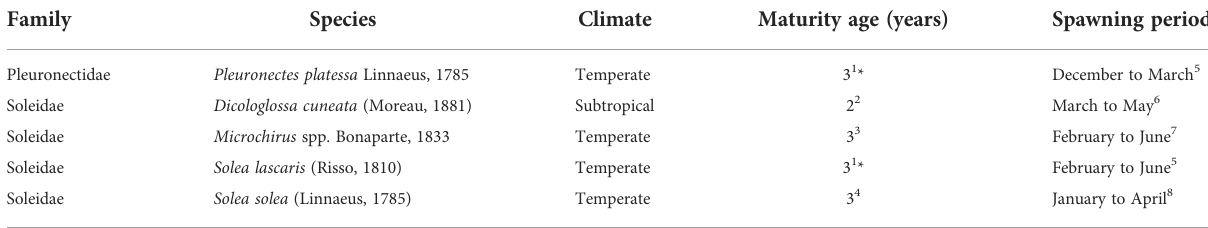
The * indicates that the study area found in the literature was in a location with different climatic conditions that one ’ s presented in Western Iberia Peninsula. 1 Deniel (1990) (France), 2 Dinis (1986)(Portugal), 3 Afonso-Dias et al.(2005)(Portugal), 4 Borges(2010) (Portugal), 5 Fe ́ lix etal.(2011) (France), 6 Santos andLino(2010) (Portugal), 7 Andrade(1990), 8 Vinagreet al.